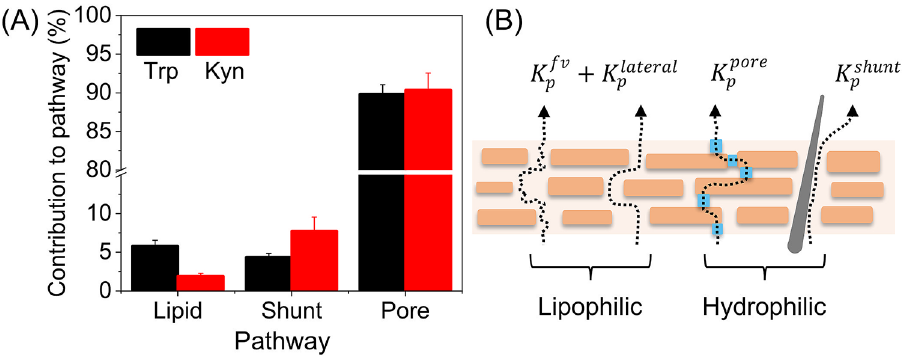
Figure 7. ( A ) Theoretical contribution of each permeation pathway of the total skin permeability of Trp and Kyn (%) based on data from pH 2.0, 5.5, 7.4, 8.8, and 12.0, see Table S7. The lipid category represents both the free-volume and the lateral diffusion pathways via the lipid lamellar matrix. ( B ) Schematic illustration of the different diffusion pathways considered in the four permeation pathways